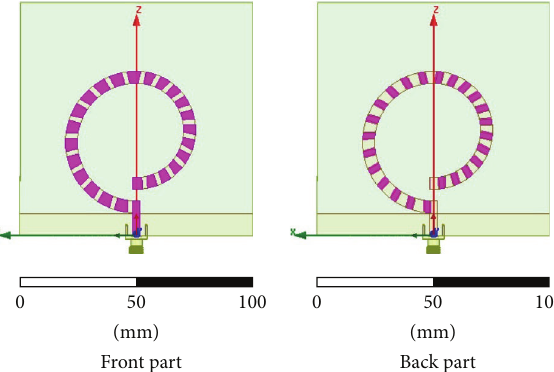
Figure 4: Spiral slotted antenna simulation.